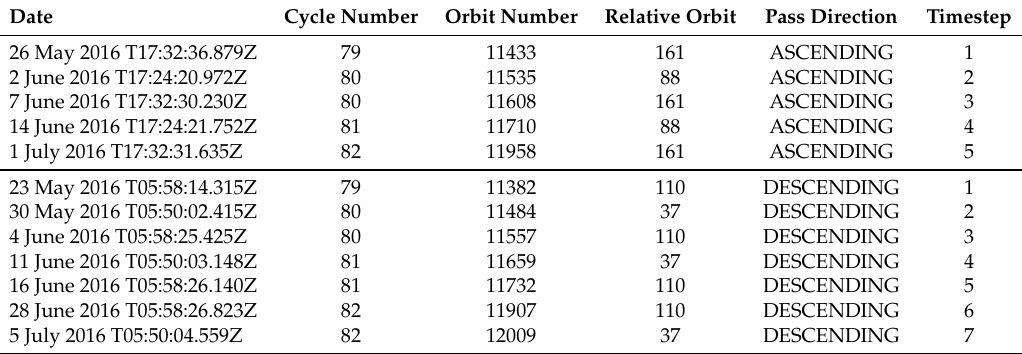
Table 1. Available Sentinel-1 Ground Range Detected (GRD) imagery before, during, and after the flood event of 7 June